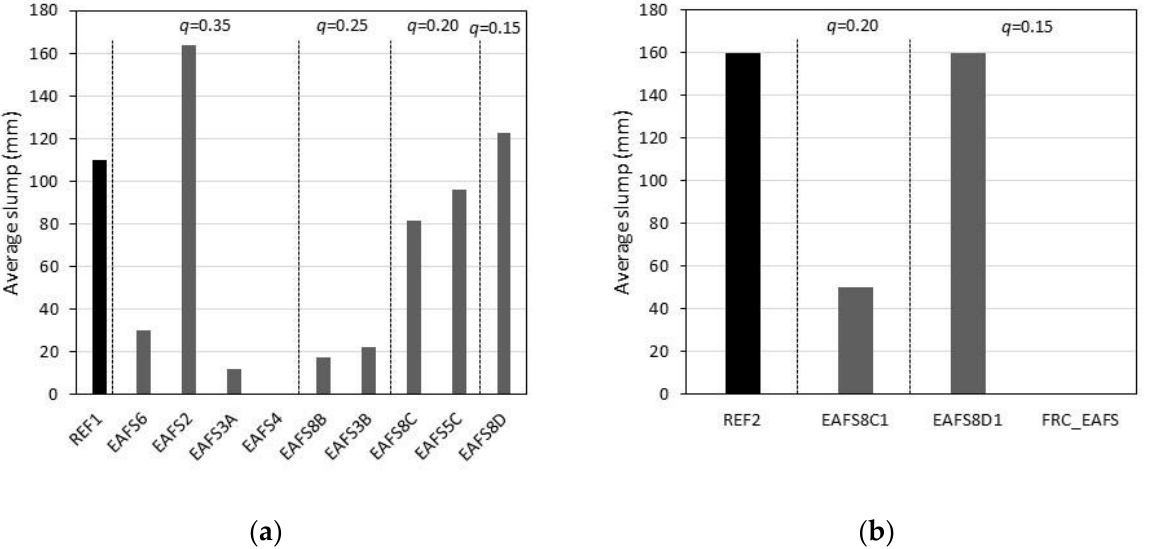
Figure 9. Results of average slump: ( a ) for REF1 and mixtures designed with EAFS; ( b ) for REF2 and mixtures designed with EAFS.